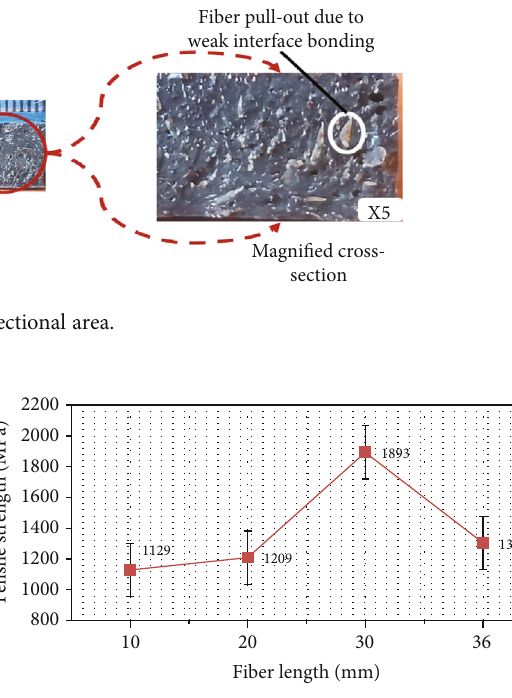
Figure 5: E ff ect of fi ber length on tensile